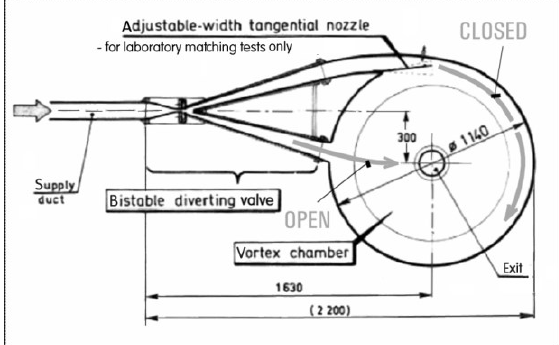
Fig. 18. The diverter from Fig. 7 was converted into a bistable OPEN/CLOSED valve. by attached vortex chamber. Advantage of this turn-down valve design is use of an previously well developed diverter part with known properties.